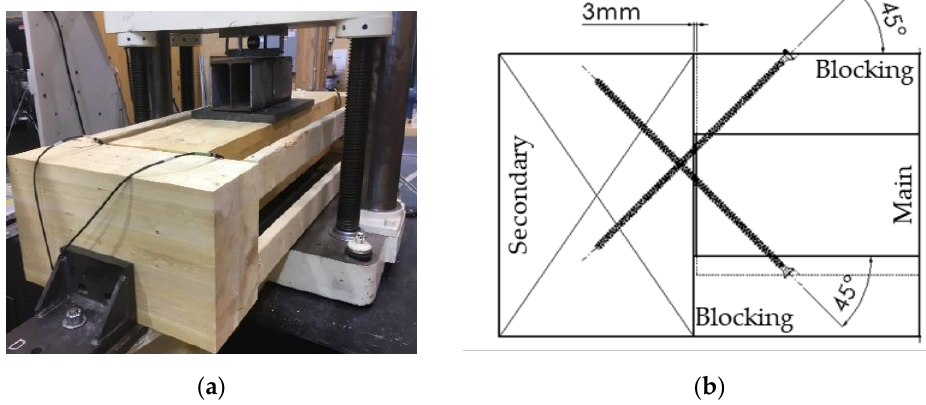
Figure 4. Vertical load test: ( a ) Experimental setup; ( b ) STS connections with full-length penetration.